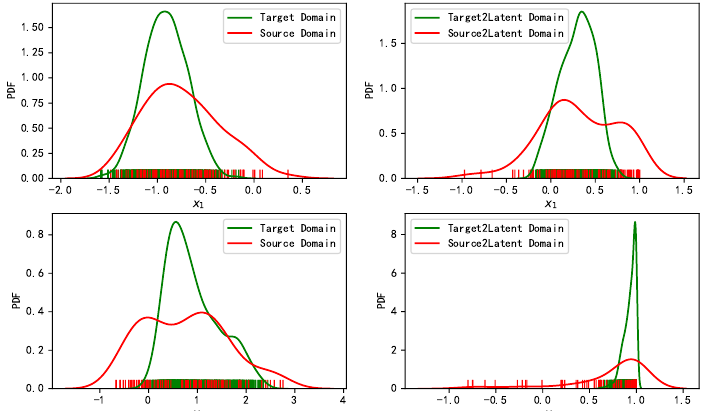
Figure 3. Fitted distributions of features in the source domain and target domain ( left ), and the fitted distributions of features after TCA transformation to the latent space ( right